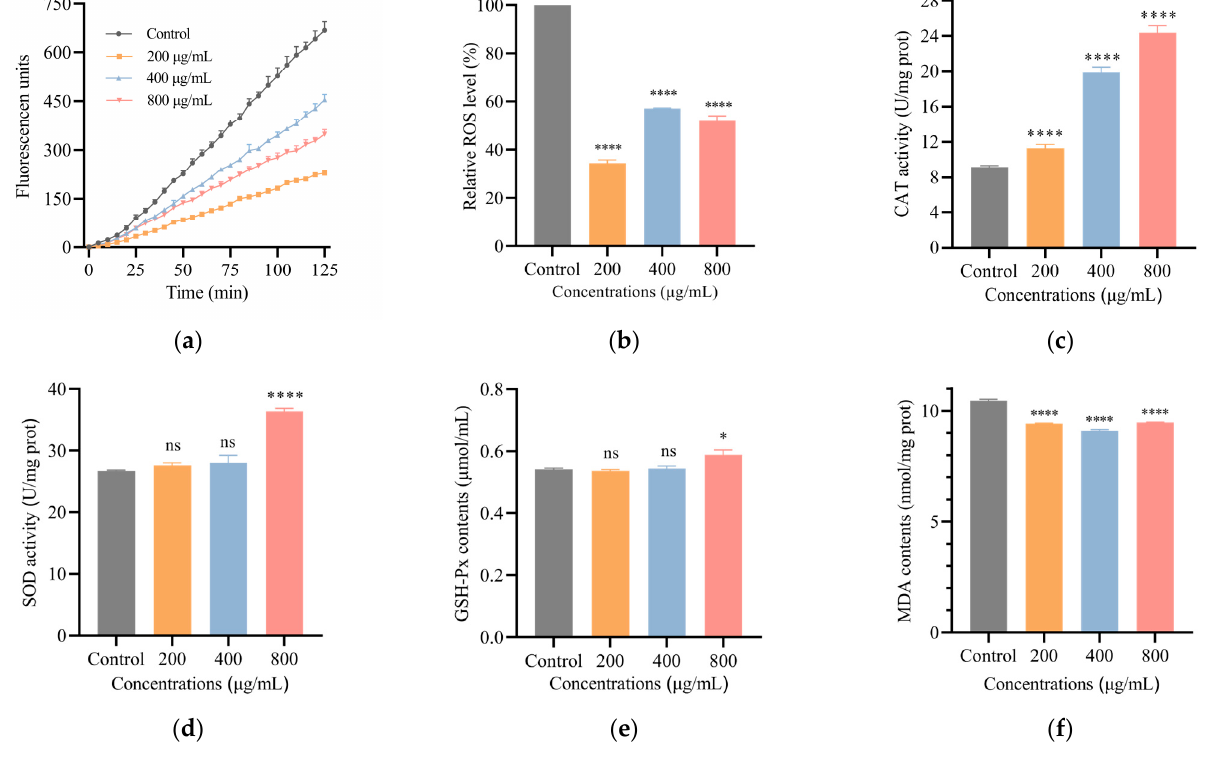
Figure 4. Groups ( a ) and ( b ) show the real-time changes in ROS and the maximum relative levels of ROS after 2 h. ( c – e ) show the CAT, SOD and GSH-Px antioxidant enzyme activities in nematodes. ( f ) shows the MDA content in nematodes. Three independent experiments were carried out for all indicators. Data are shown in mean ± SD, n = 3. Notes: The asterisk (* and ****) represents the degree of significant difference. The higher the number, the more significant; ns means not significant.